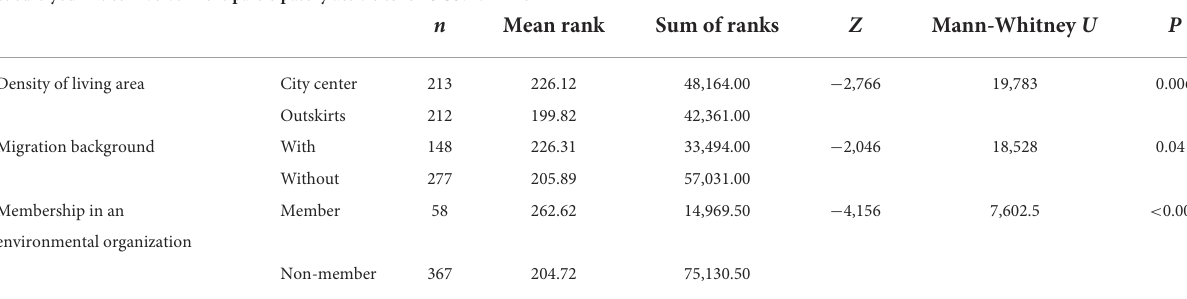
TABLE 1 Mann–Whitney U -test results for the participation willingness per